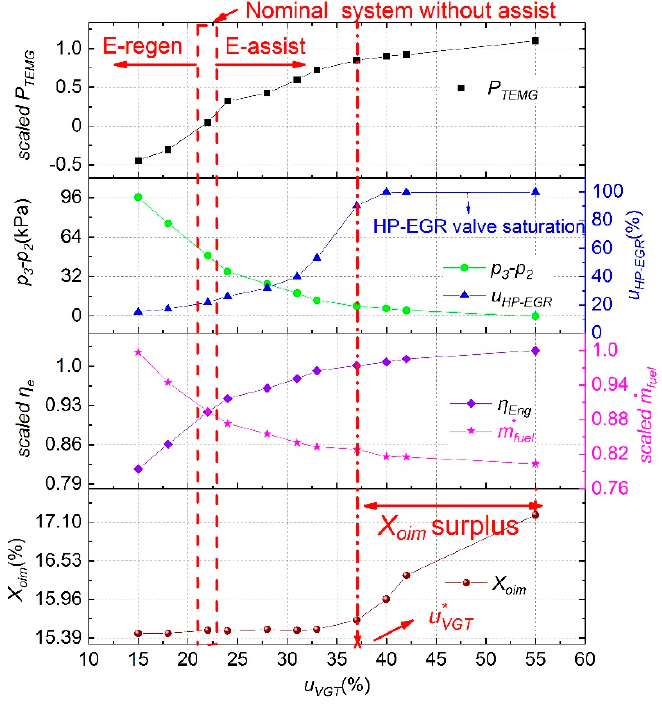
Figure 5. Engine fuel efficiency improvement and X oim surplus.